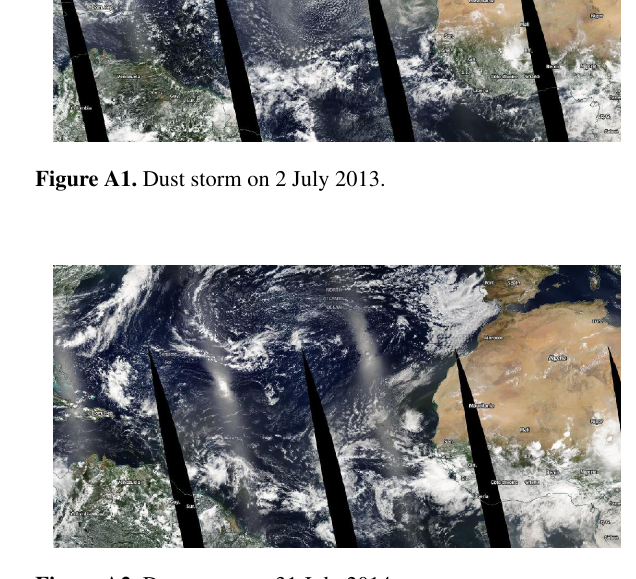
Figure A2. Dust storm on 31 July 2014.